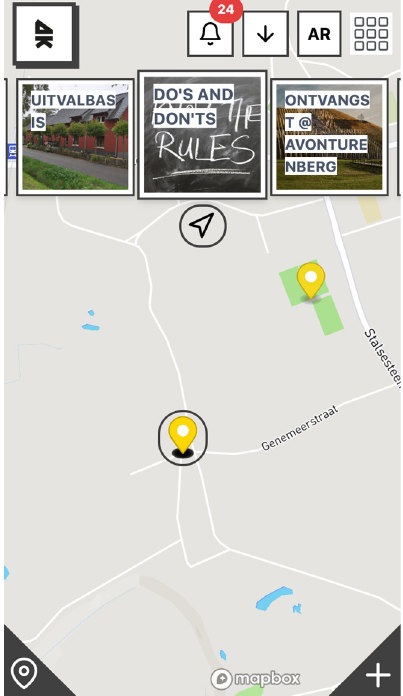
Figure 13. TICKLE’s card interface for the Reboot Camp.